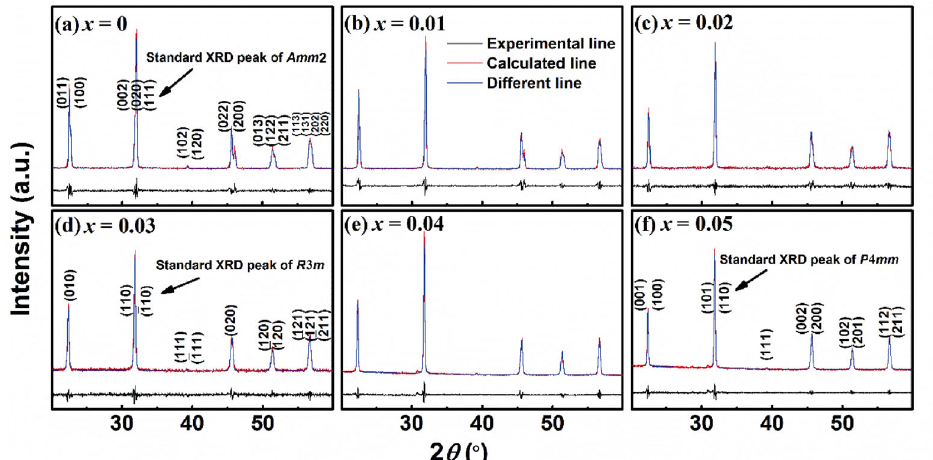
Fig. 1 XRD patterns and Rietveld refinement of (0.99– x )KNNS–CZ– x BNH ceramics: (a) x = 0, (b) x = 0.01, (c) x = 0.02, (d) x = 0.03, (e) x = 0.04, and (f) x =